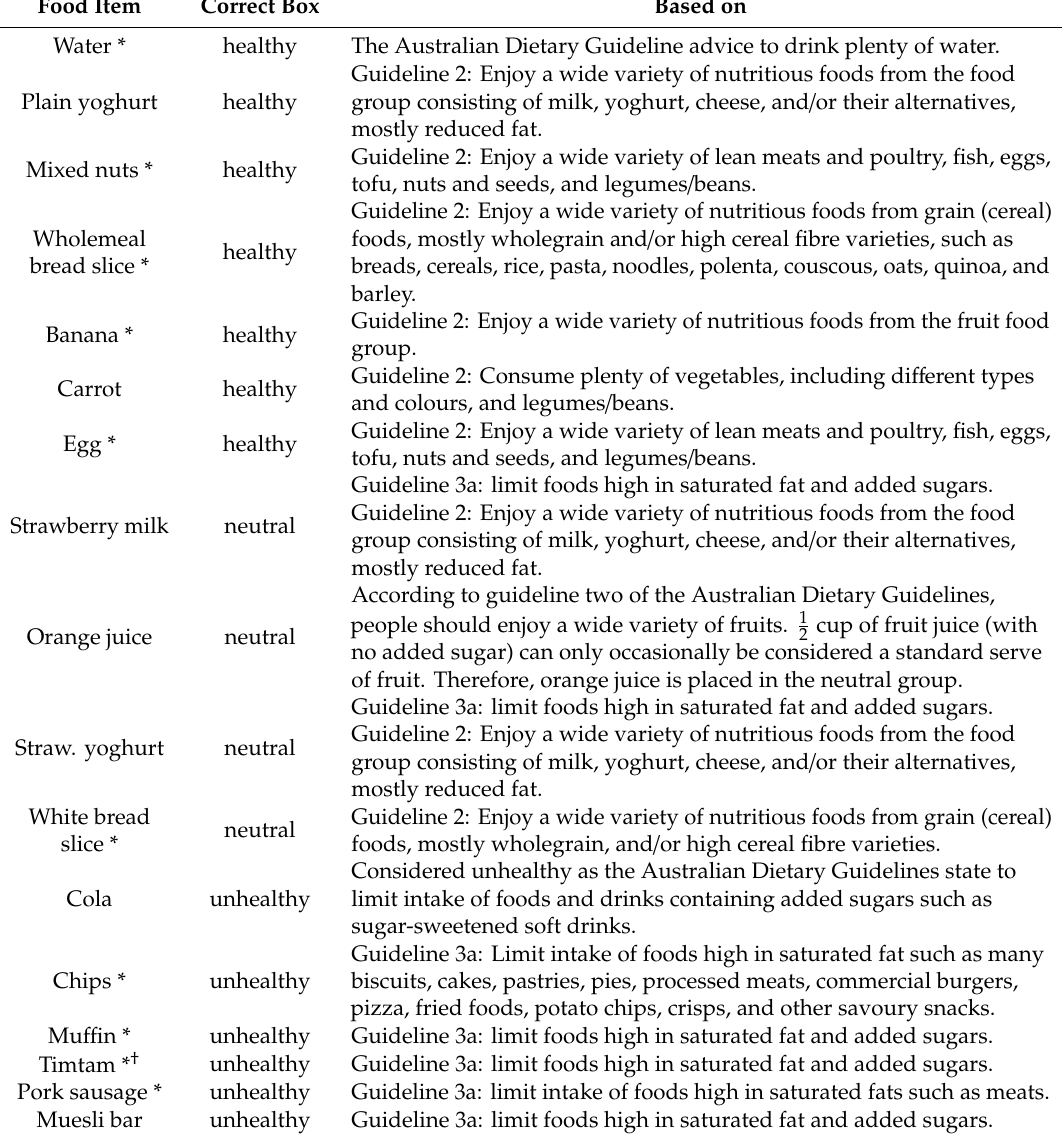
Table 1. Sorting foods in the right box, correct answers based on National Health and Medical Research Council